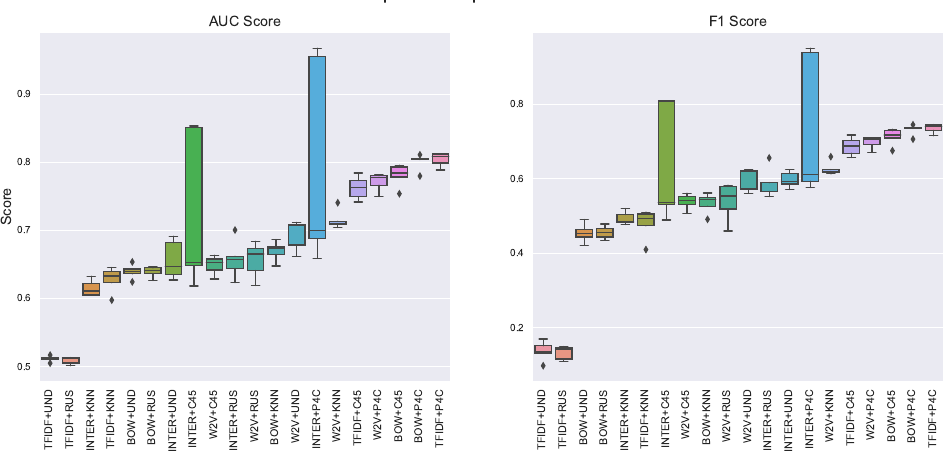
( b ) Results for the Pitropakis Xenophobia Database. Figure 6. Box-and-whisker plots for the AUC and F1 score metrics. The boxes are sorted in ascending order according to their median. The boxplots are very useful to compare the distribution between many groups where each box of the boxplot represents the distribution of a group. In our case, each box represents the combination’s results for both AUC and F1 score metrics presented in Table 9. Boxplots show the next five-number summary of a